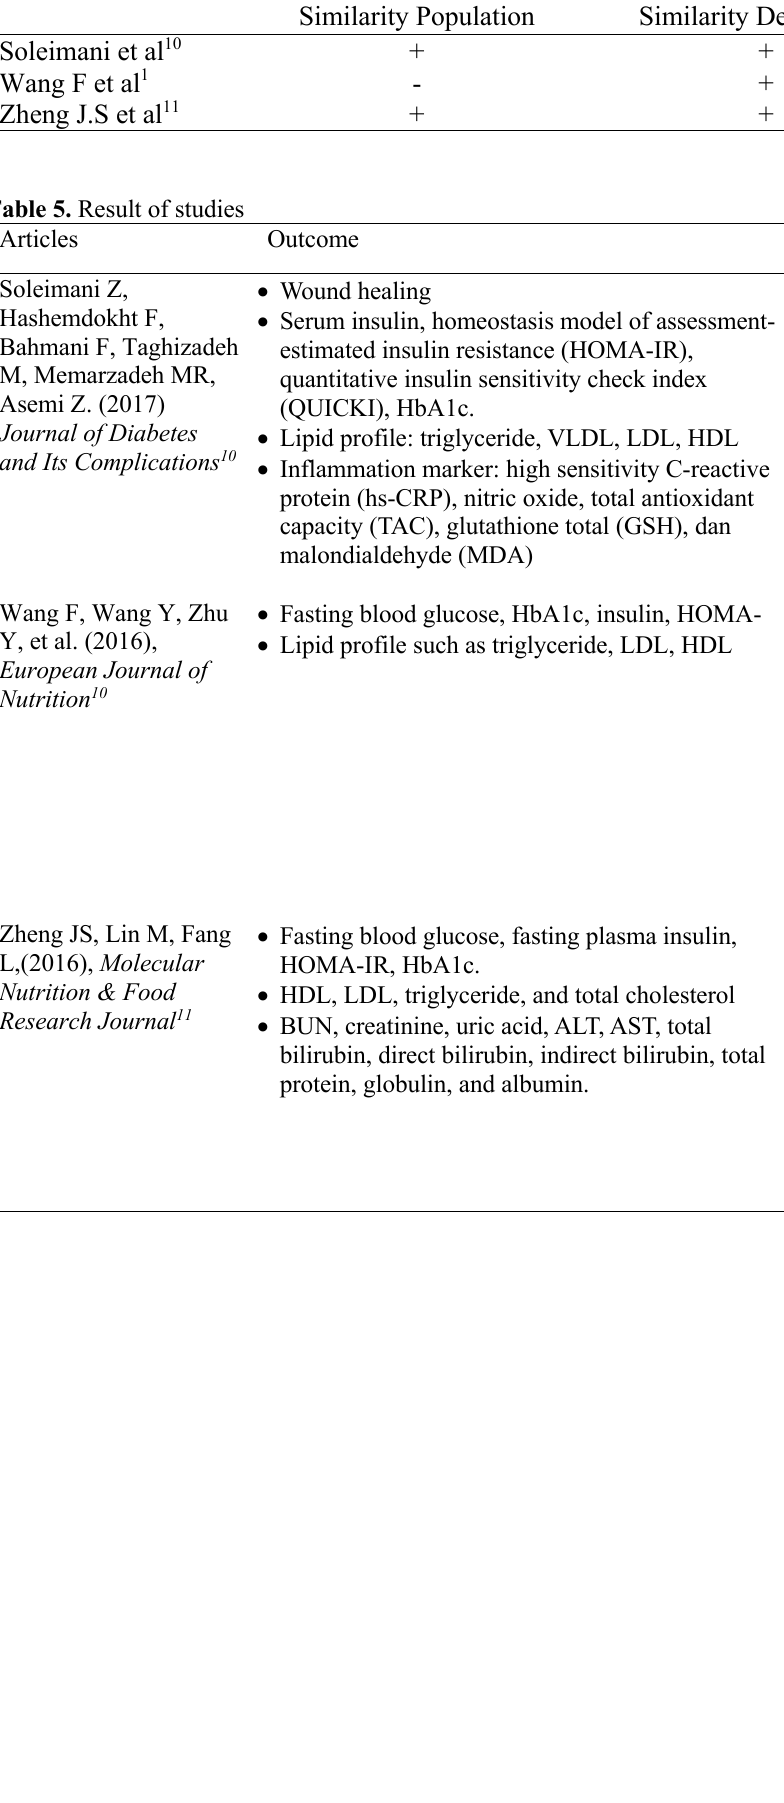
Table 4. Relevance criteria